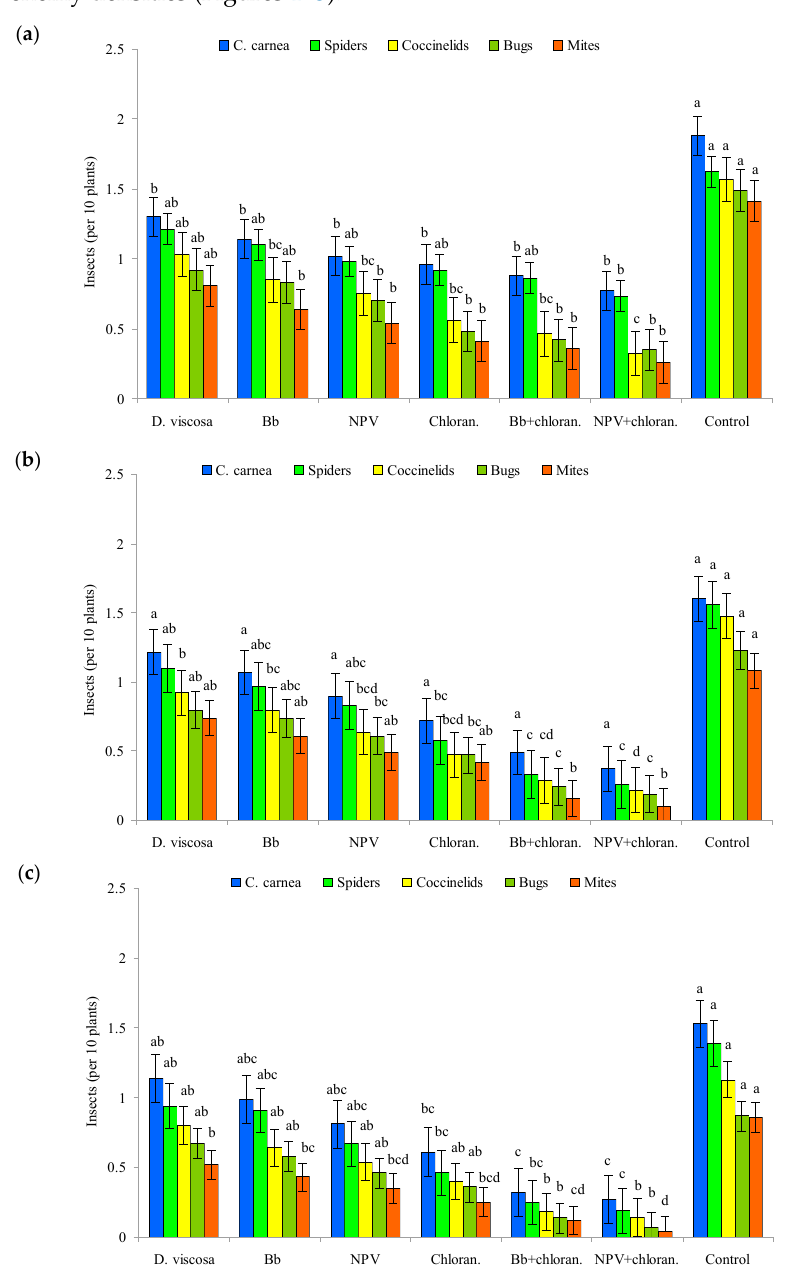
Figure 1. Population density (mean number per ten plants ± SE) of natural enemies following field application of different biorational and chemical control options based on B. bassiana ; HaNPV; D. viscosa and chlorantraniliprole (chloran.) at ( a ) 3 DAT, ( b ) 5 DAT and ( c ) 7 DAT after the second spray at Rawalpindi. Means followed by the same letters are not significantly different from each other within each sample time and for each natural enemy taxon; Tukey-Kramer HSD test at p = 0.05.